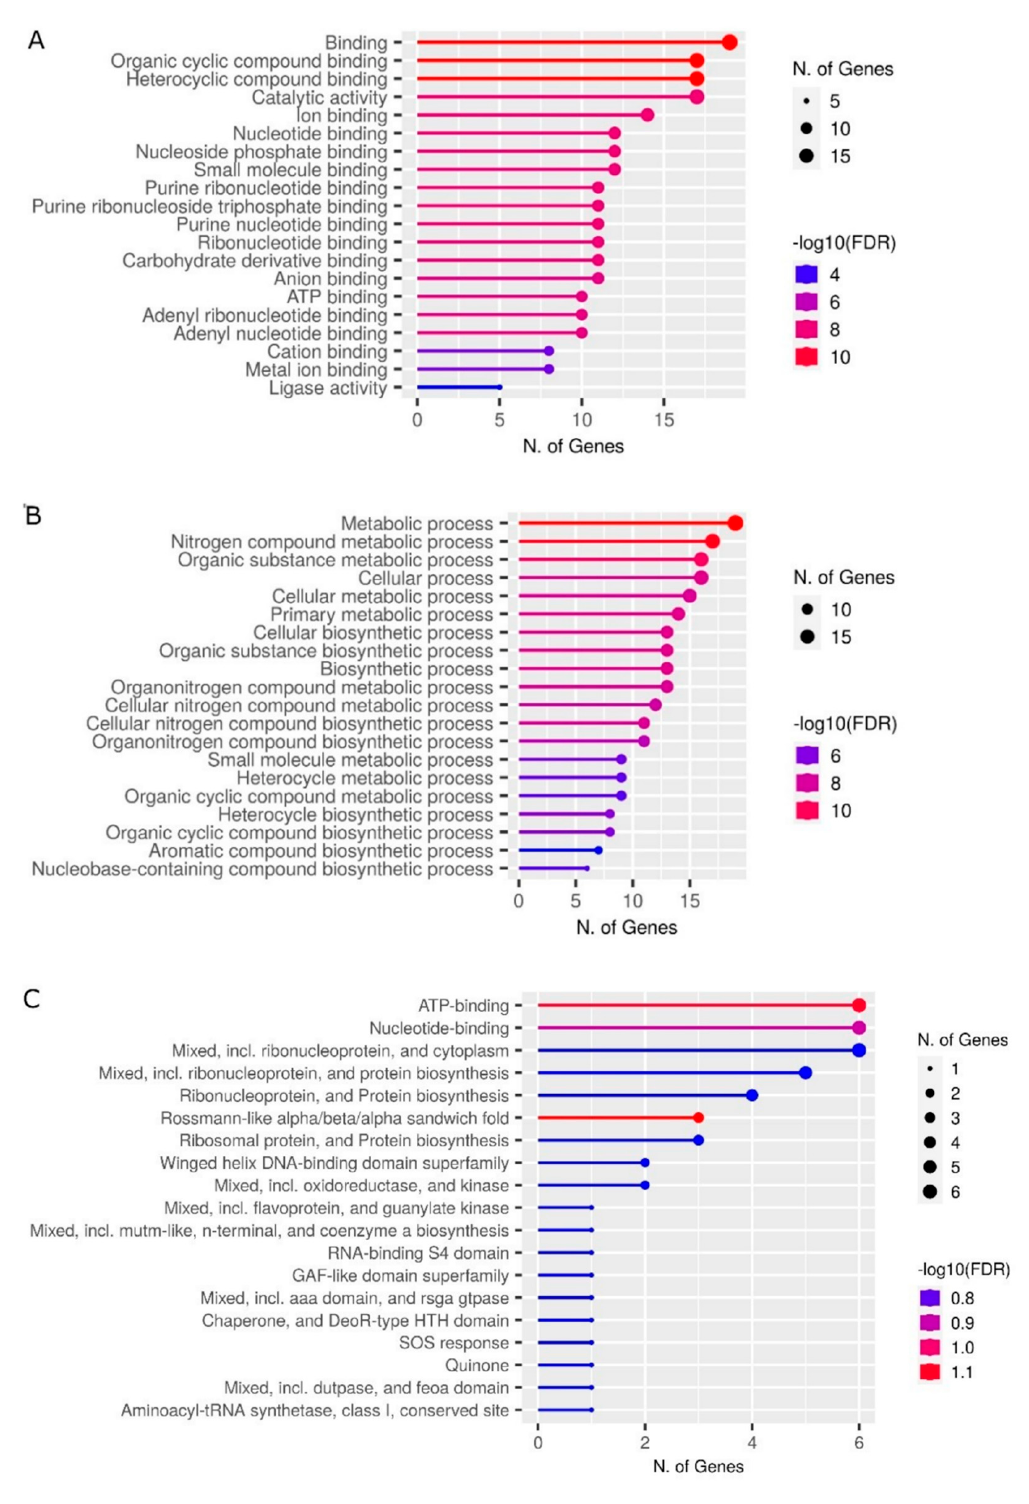
Figure 5. ( A ) Molecular function, ( B ) biological process, and ( C ) all-available gene set categorization in Gene Ontology terms of representative bacterial genome ( Acenitobacter sp.). Lollipop chart at aspect ratio 1.5 and -log10 (FDR) heat maps for each category are shown. FDR is calculated based on nominal p -value from the hypergeometric test. FDR shows how likely the enrichment is by chance. Larger gene sets tend to have smaller FDR. N. of Genes indicates the number of genes for each category.